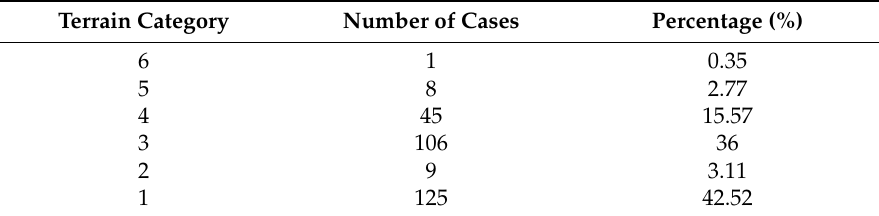
Table 5. Damage cases based on LULC